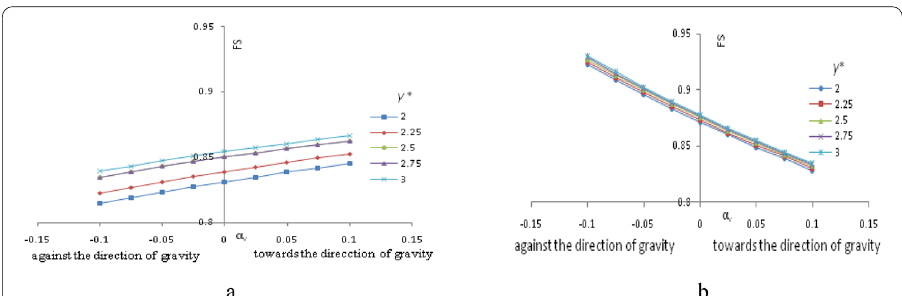
Fig. 8 FS vs α v on different values of γ *: a case 1 and b case 2